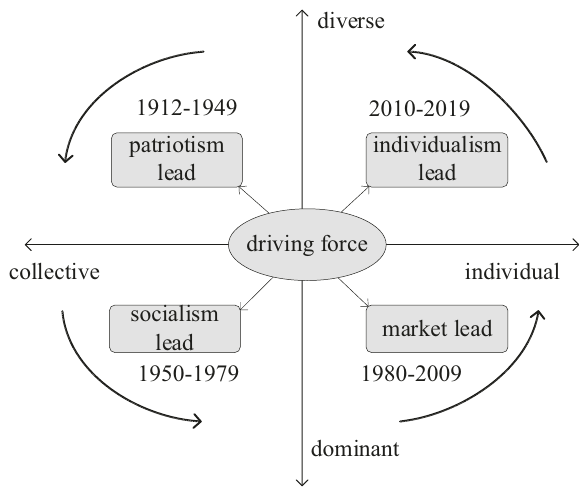
Fig. 1 Conceptual framework and transaction of sense of place. Conceptual framework and transaction of sense of place indicate that as the social situation changes, the characteristics and connotations of the mainstream sense of place in society will change accordingly, shifting from collective to individual and from dominant style to the diverse